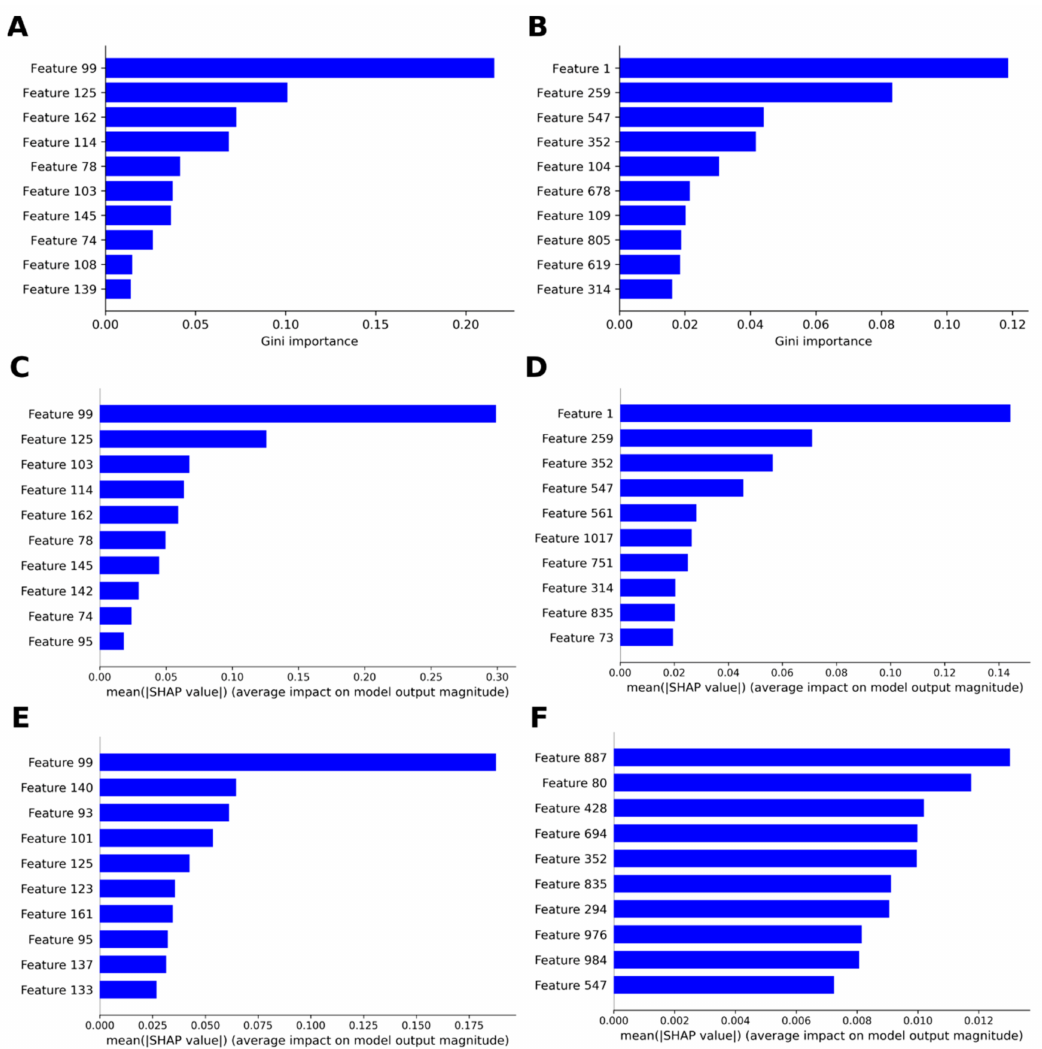
Figure 8. Relevant structural features for machine learning models. ( A ) Gini importance for M1, ( B ) Gini importance for M2, ( C ) SHapley Additive exPlanations (SHAP) values for M1, ( D ) SHAP values for M2, ( E ) SHAP values for M3 and ( F ) SHAP values for M4. Only the ten top features are